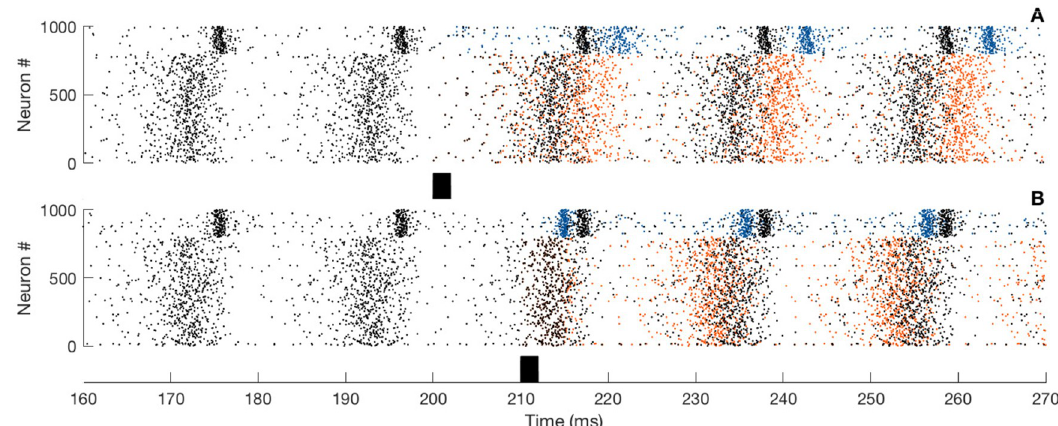
Fig 11. Phase shifting. A-B) Spiking activity obtained from simulations of the full spiking network. The black dots illustrate the ongoing activity and the colored dots (blue for the I-cells and red for the E-cells) the activity of the perturbed network. Lower panels: Illustration of the stimulus onset. Perturbations are made on the I-cells. Parameters: N �